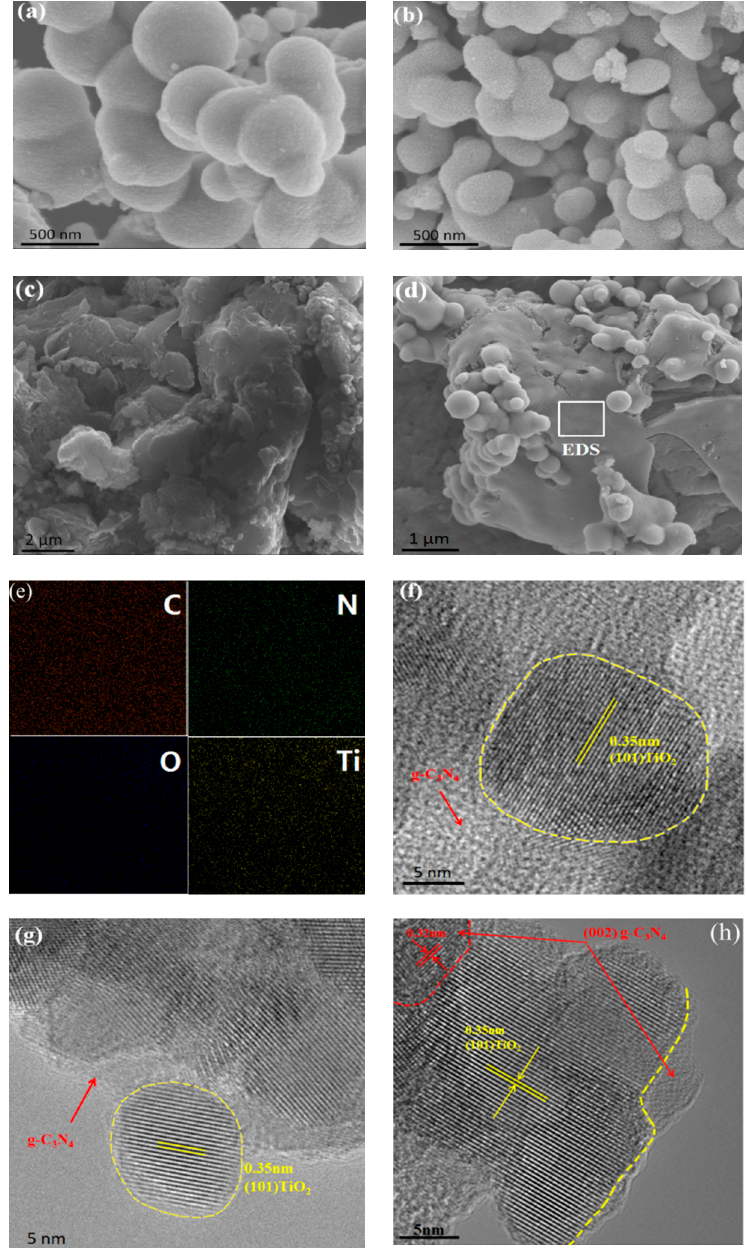
Figure 5. SEM images of ( a ) TiO 2 -C, ( b ) TiO 2 -D, ( c ) g-C 3 N 4 , ( d ) TCN50-D and ( e ) EDS elemental mappings of TCN50-D samples; high-resolution transmission electron microscopy (HRTEM) images of ( f ) TCN50-C sample, ( g , h ) TCN50-D sample.